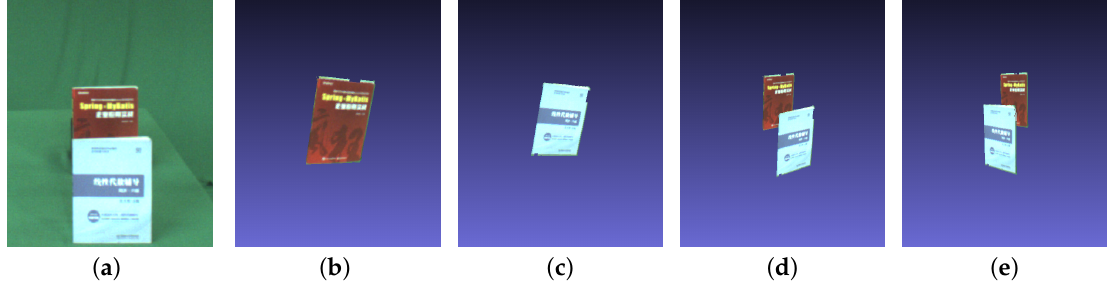
Figure 7. Reconstruction result of the book scene. ( a ) Reference camera view of the book scene. ( b ) Reconstruction result of the book behind. ( c ) Reconstruction result of the front book. ( d , e ) Reconstructed book scene observed from different